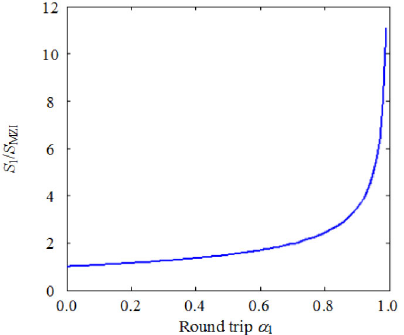
Fig. 3 Sensitivity enhancement factor for the proposed sensor, calculated with the first sensing arm.